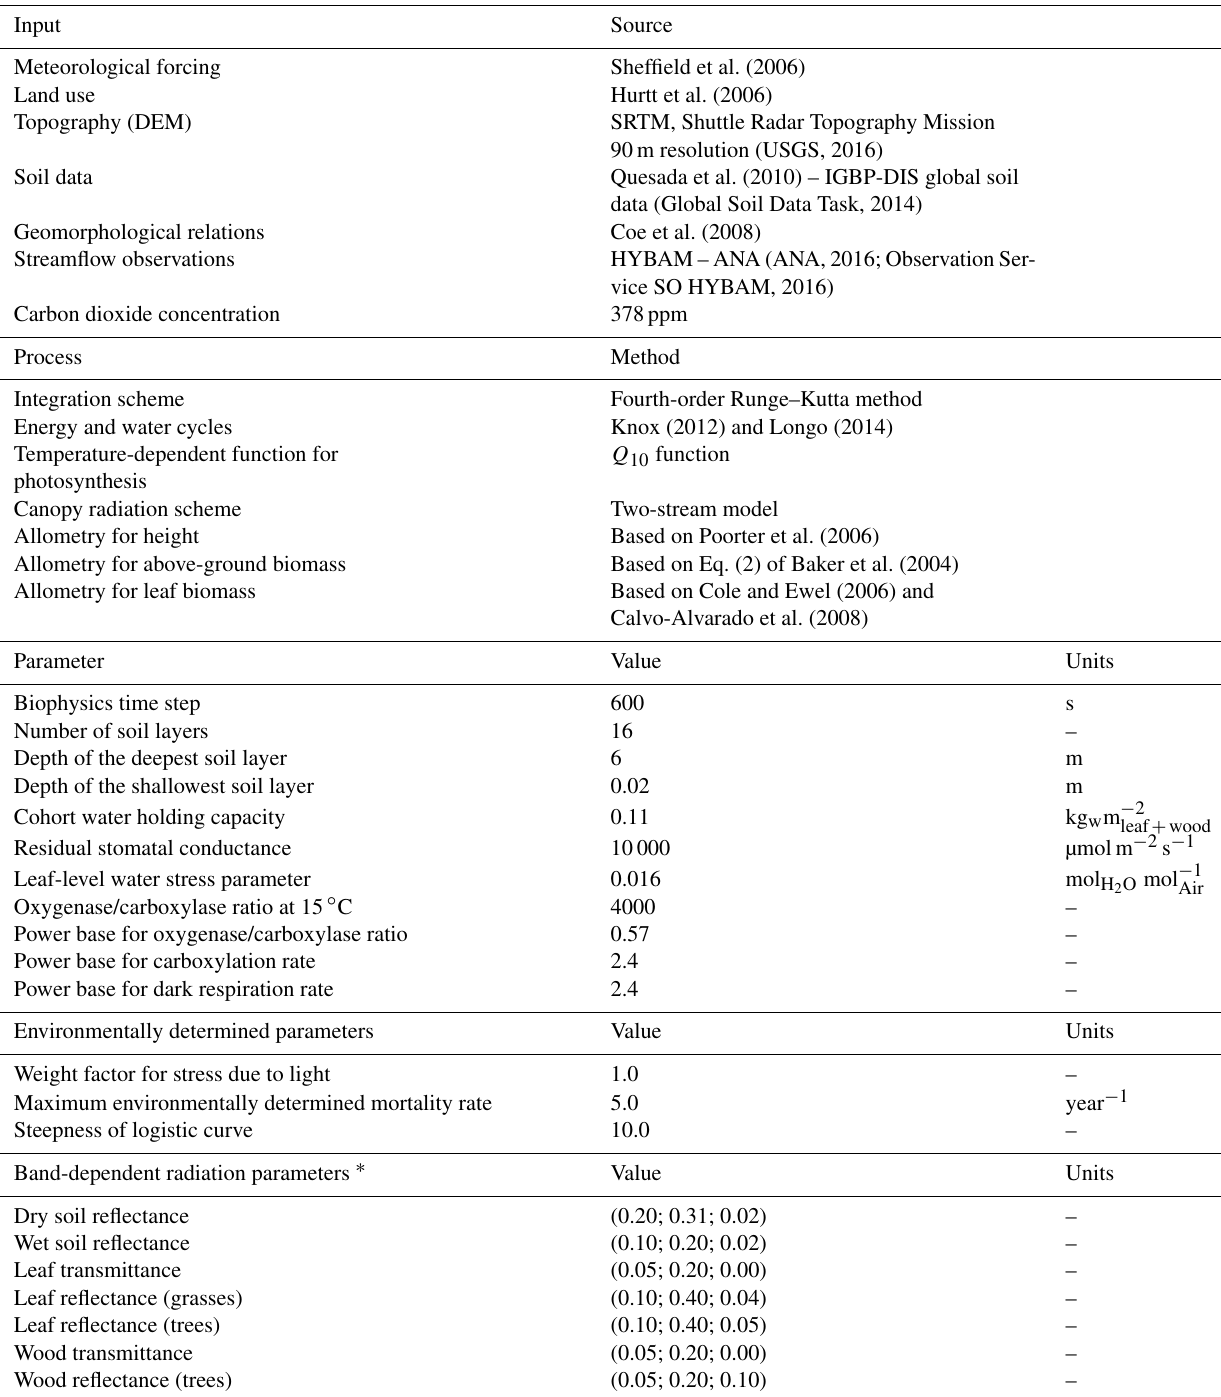
Table 1. ED2 + R calibrated parameters (based on Zhang et al., 2015; Longo, 2014; Knox, 2012). Additional information about ED2 parameter calibration for the Amazon Basin are available in Zhang et al. (2015) and Longo